Question: What does this figure show? Answer in one sentence.
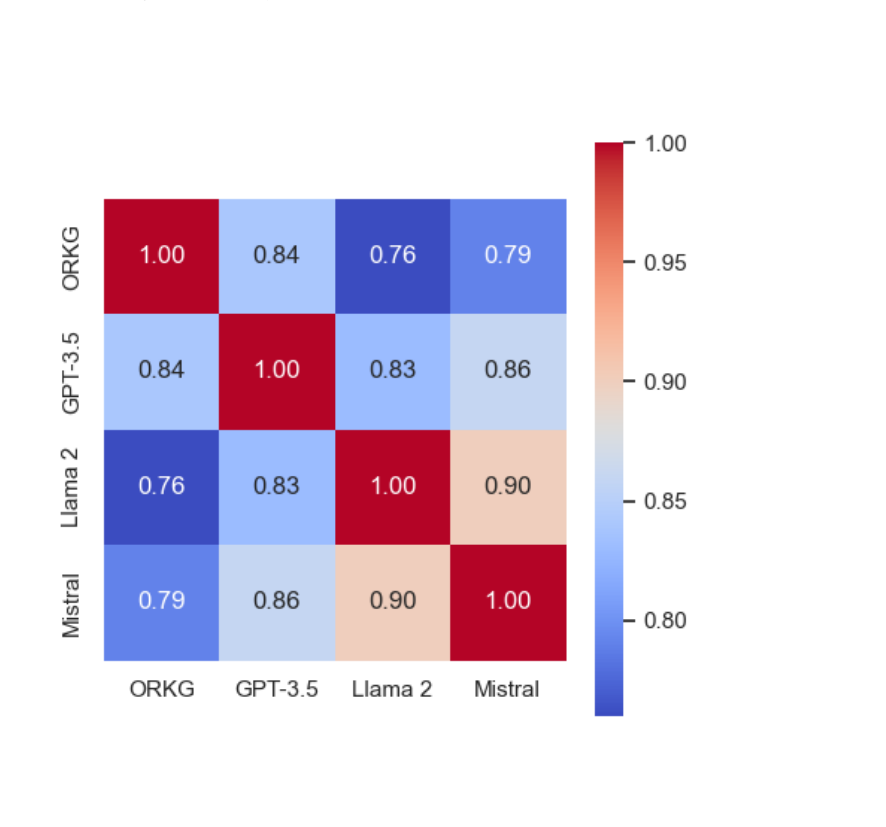
Answer: Correlation heatmap of cosine similarity between ORKG properties and LLM- generated dimensions